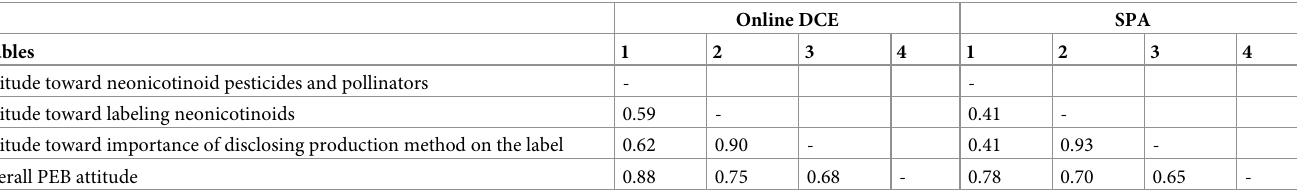
Table 4. Correlation matrix of the attitude